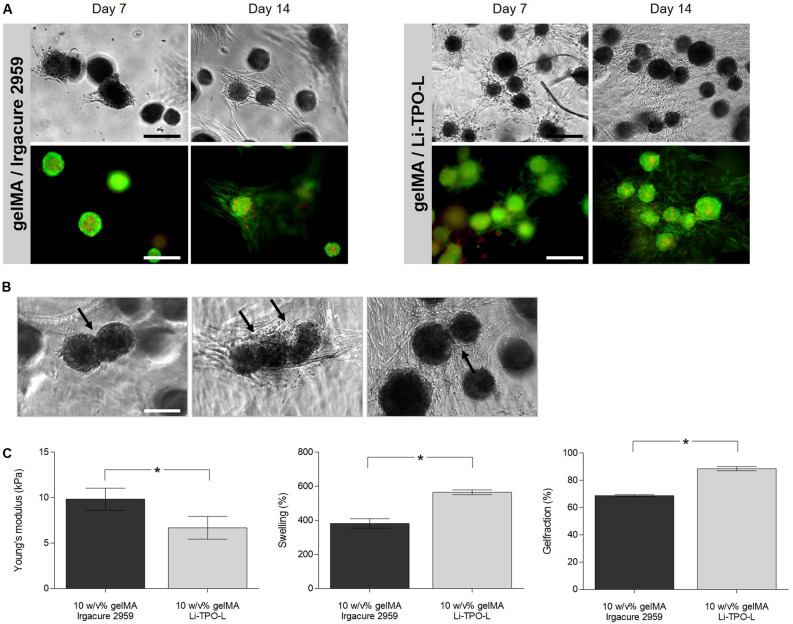
Influence of gelMA properties on spheroid morphology, viability, and fusion. (A) Cartilage microtissues at maturation stage of 14 days were harvested and were encapsulated in gelMA using either Irgacure 2959 or Li-TPO-L as a photo-initiator. Morphology and viability of encapsulated spheroids 7 and 14 days post encapsulation. Scale bars 200 μm. (B) Cellular outgrowth and fusion of 14-day-matured cartilage microtissues within gelMA after 14 days of culture in the hydrogel, fused spheroids are indicated by the black arrows. (C) Young’s modulus, gel fraction and swelling ratio were assessed on cell-free gelMA hydrogel samples (n = 5, independent samples t-test). All data are presented as mean ± 95% CI and significant differences were marked as *p < 0.05.